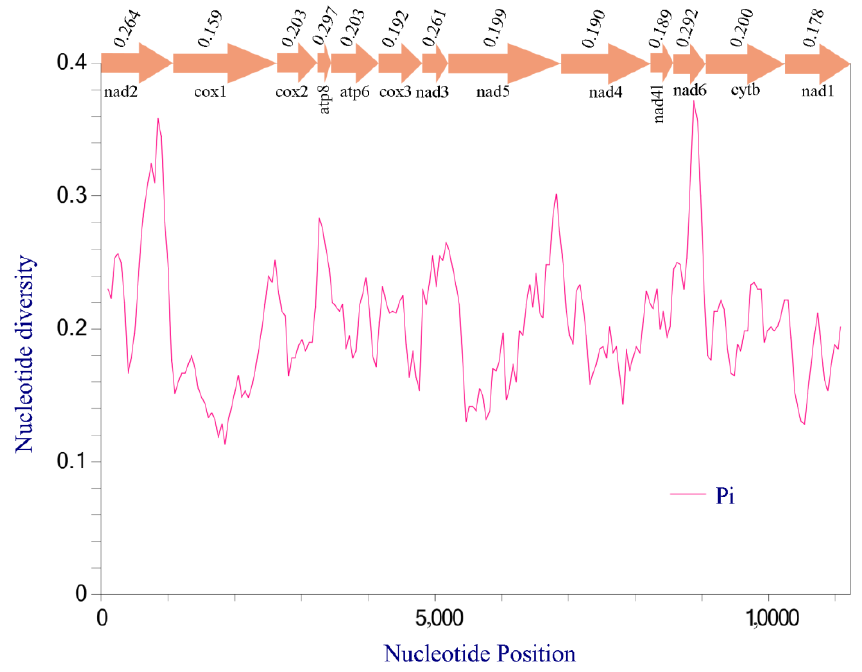
Figure 4. Nucleotide diversity (Pi) of 13 PCGs in three newly sequenced buprestid mitogenomes.